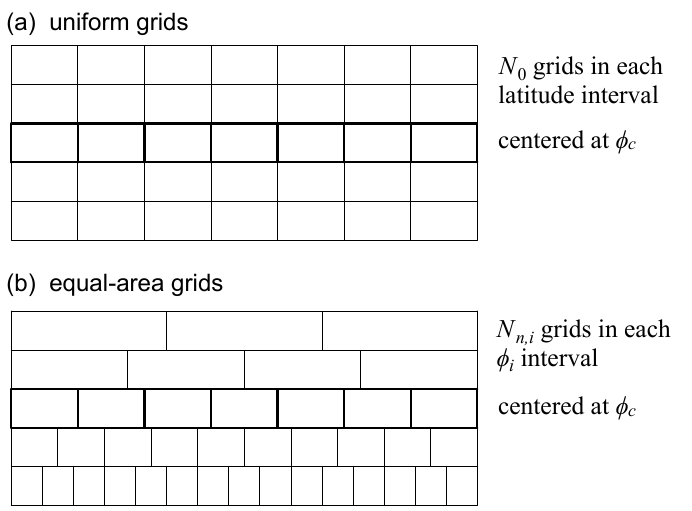
Figure 1. An illustrative example of converting ( a ) uniform latitude–longitude grids to ( b ) equal-area isolatitudinal grids. There are constant N 0 grids in each latitude interval in ( a ) but varying N n , i grids in ( b